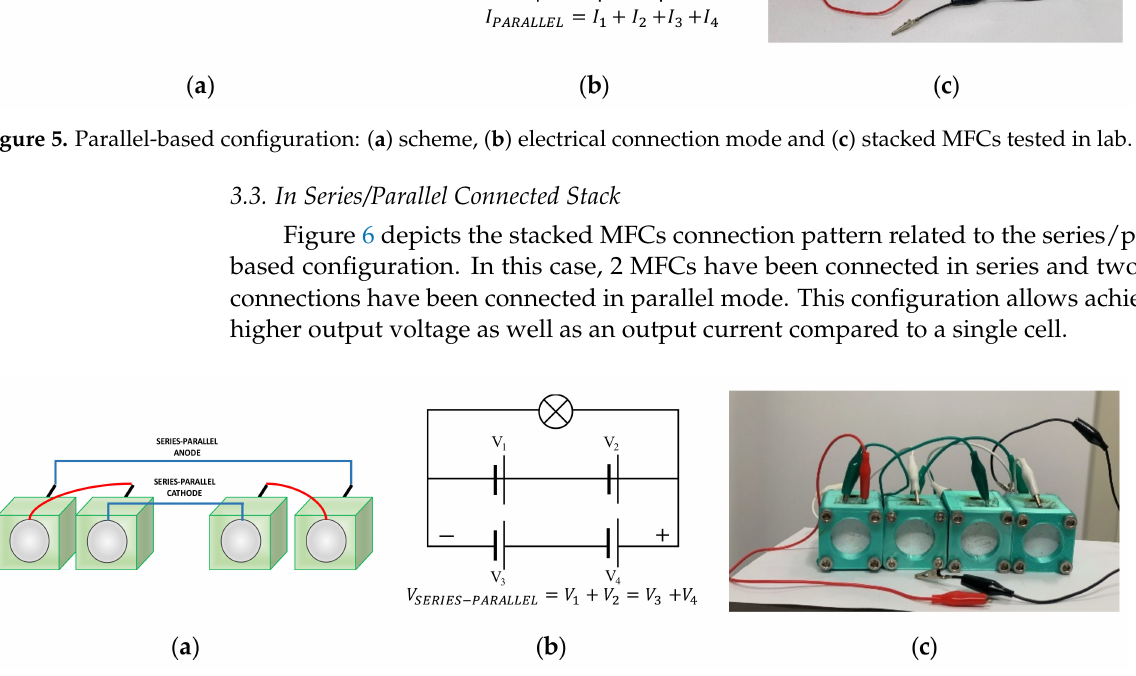
Figure 6. Series/parallel-based configuration: ( a ) scheme, ( b ) electrical connection mode and ( c ) stacked MFCs tested in